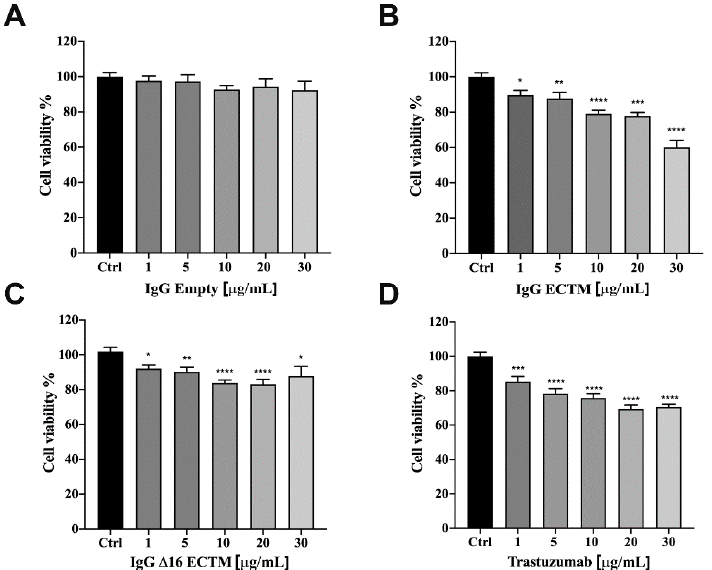
Figure 5. IgG purified from ECTM- and ∆ 16ECTM-immune sera decreased cell viability in trastuzumab sensitive-BT-474 BC cells. Cells were incubated for 72 h in the presence of increasing concentrations of control IgG ( A ), ECTM-IgG ( B ), ∆ 16ECTM-IgG ( C ) or trastuzumab ( D ) and cell viability was determined by MTT assay. The results are expressed as percentage of living cells ± SEM with respect to control (untreated cells). Columns show the means of results obtained in three sepa- rate experiments, wherein each treatment was repeated in 6 wells. One-way ANOVA followed by Dunnett’s post-hoc tests (* p < 0.05; ** p < 0.01; *** p < 0.001; **** p < 0.0001 vs.